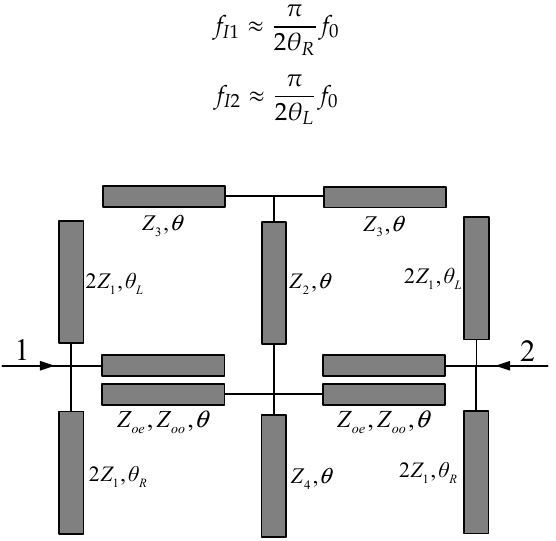
Figure 4. The revised topology for theoretical analysis ( θ L = θ 1 + θ 2 , θ R = θ 1 + θ 3 ).